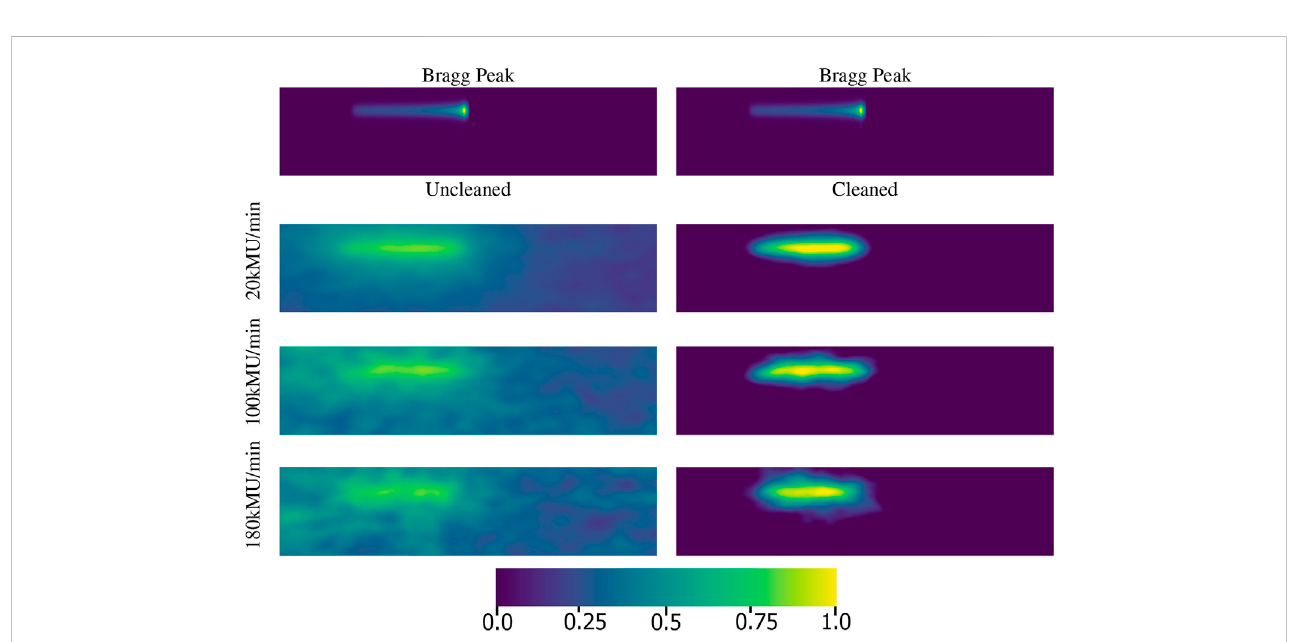
FIGURE 3 The fi rst row contains a reconstruction of the proton beam with a Bragg peak at the end of its range. The second, third, and fourth rows are reconstructionsofPGdatarecordedat20 kMu/min,100 kMU/min,and180 kMU/mindoserates,respectively.TheleftcolumnusesPGdatawithoutusingthe NN classi fi cation for data correction, called the “ uncleaned ” data. The right column uses PG data after it has been NN classi fi ed and corrected, called the “ cleaned ” data. Each image is 120 by 512 pixels and each pixel represents a 1 mm 2 area. The images are normalized such that pixels with no energy depositions are the darkest with a value of 0.0 and the pixels with the maximum energy deposition are the brightest with a value of